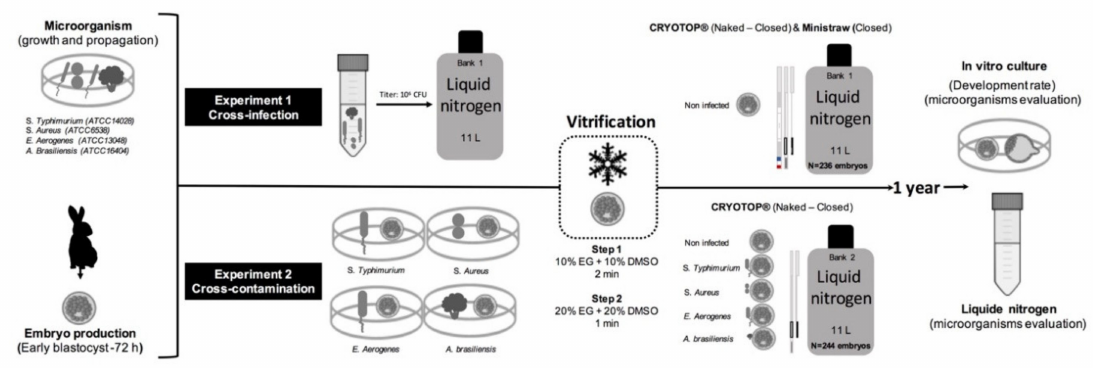
Figure 1. Schematic diagram of the experiments carried out to evaluate both cross-contamination and cross-infection risk of embryo storage in liquid nitrogen biobanks. In experiment 1, cross-infection between artificially contaminated liquid nitrogen with 10 6 CFU of Salmonella Typhimurium, Staphylococcus aureus , Enterobacter aerogenes and Aspergillus brasiliensis and vitrified embryos stored in Cryotop (closed and naked) and mini-straw devices were assessed. In experiment 2, cross-contamination between artificially infected fresh embryos, vitrified and stored in Cryotop (closed and naked) and liquid nitrogen was